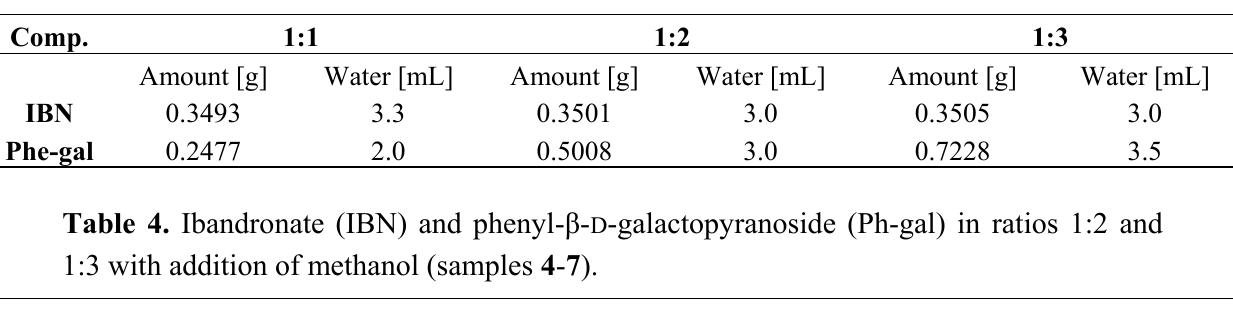
Table 3. Ibandronate (IBN) and phenyl- β - D -galactopyranoside (Ph-gal) in ratios 1:1, 1:2 and 1:3 (samples 1 - 3 ).